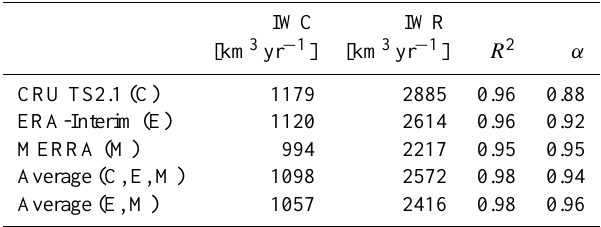
Table 2. Correlation of simulated IWR to reported statistics per country for the year 2000 ( N = 212). IWR was simulated with the CRU TS2.1 (C), ERA-Interim (E), and MERRA (M) climate, re- spectively. Average indicates the mean of the two or three results. Reported statistics were obtained from the FAO AQUASTAT data base (globe: 2434km 3 yr − 1 ) . R 2 and α denote the coefficient of determination and the slope of regression line respectively. R 2 was derived from the comparisons between normal values. The value with the CRU TS2.1 climate is provided for a reference and is not included in our overall analysis. The values of irrigation water con- sumption (IWC) is also provided under each